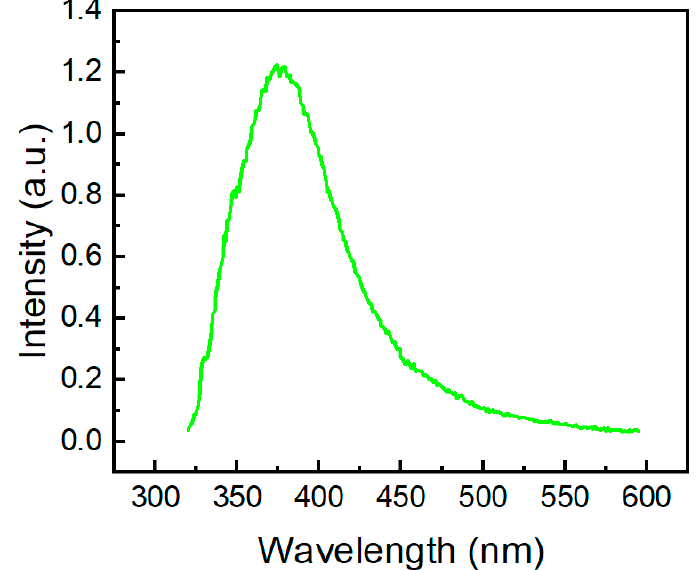
Figure 9. Fluorescence spectrum of molecule 2a in DMSO excited at 300 nm.